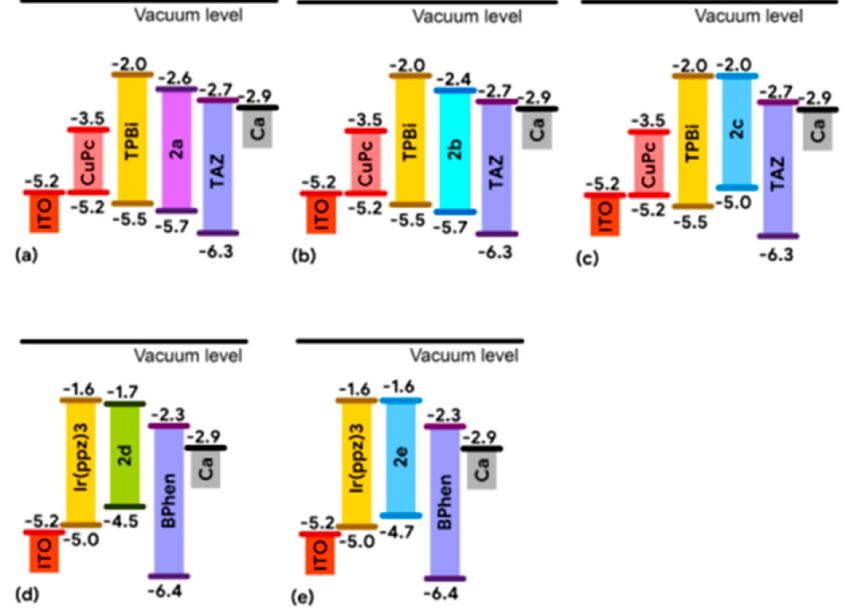
Figure 6. Energy band diagrams of OLED devices using ( a ) 2a , ( b ) 2b , ( c ) 2c , ( d ) 2d , and ( e ) 2e as the emissive layer.